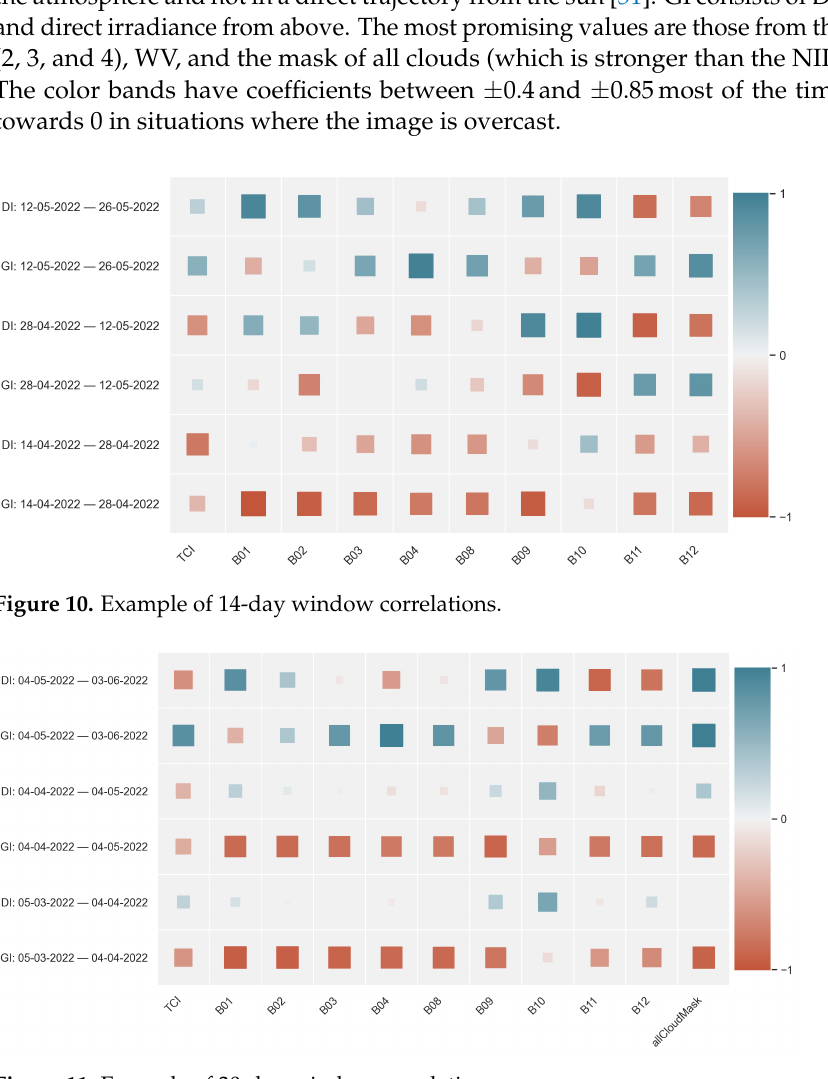
Figure 11. Example of 30-day window